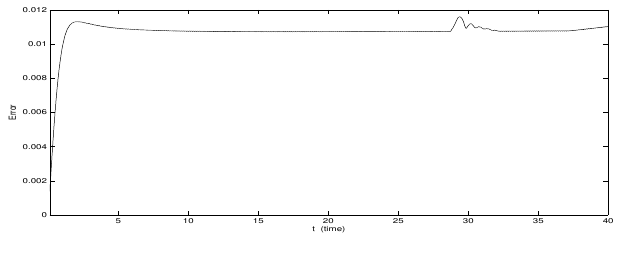
We point out that the parameter a 0 controls the initial position of the solitary wave. In Figure 2 we compare the numerical solution with the approximations (5.30)–(5.31) computed at time t = 40. In Figure 3 we show a zoom of Figure 2. We see that they perfectly agree with good accuracy and neither numerical dispersion nor dissipation are evidenced in the profiles of the fluid velocity and wave elevation. The wave speed is approximately c ≈ 0 . 7109 and the initial position is a 0 = 40.